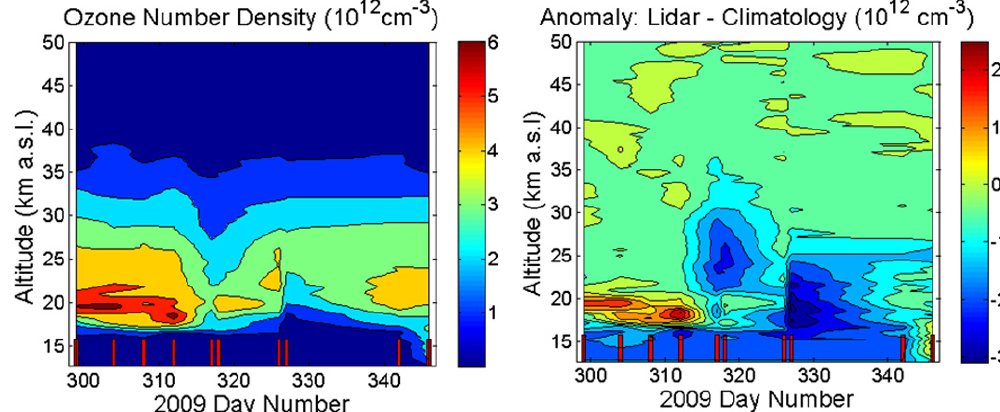
Fig. 4. 2-D time–altitude cross section of lidar ozone number density for the CEILAP-RG site (left panel). 2-D time–altitude cross section of number density anomaly (lidar–climatological profile) (right panel). Vertical red bars indicate the lidar measurements.